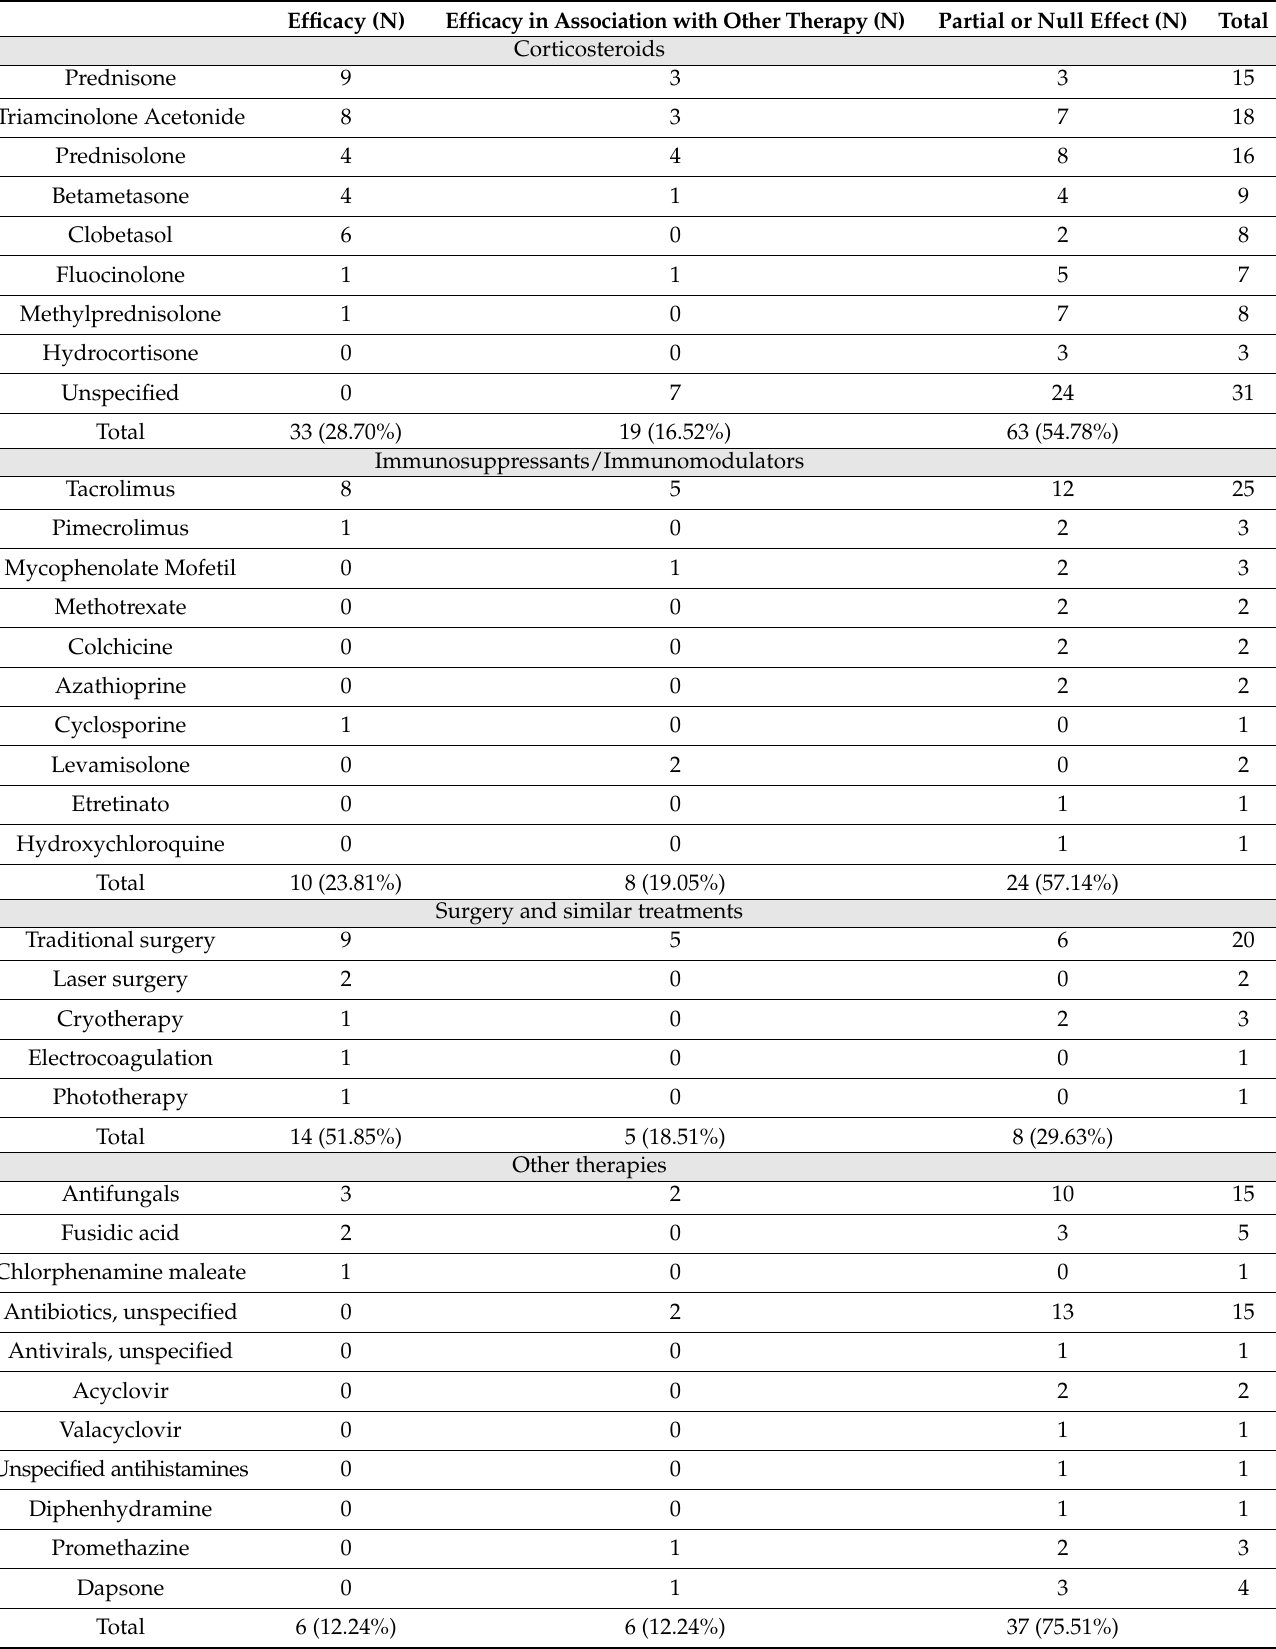
Table 5. Summary of therapeutic regimens reported in literature. Efficacy